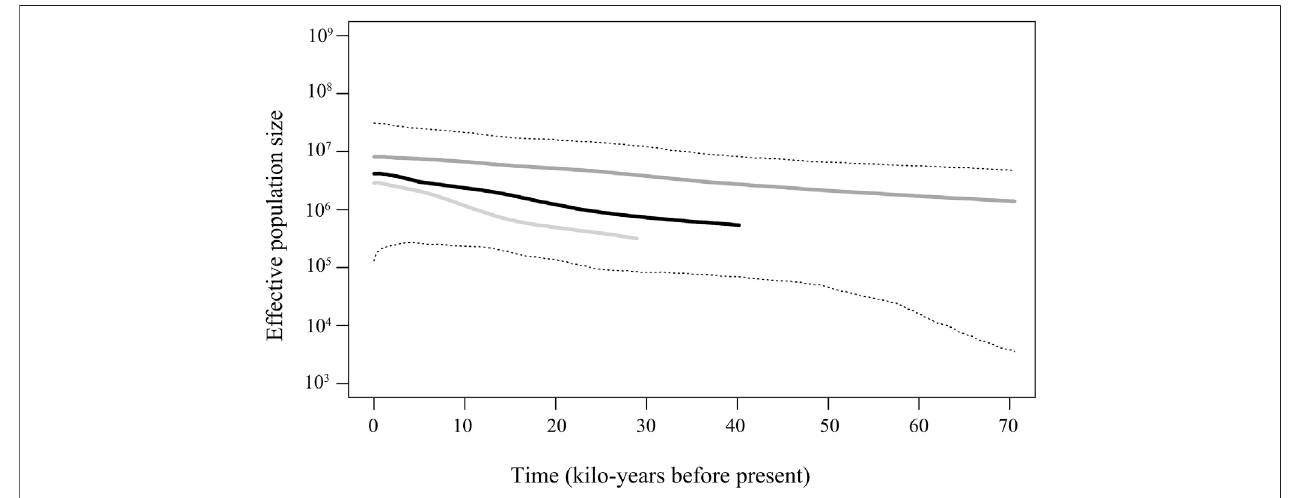
FIGURE5| Bayesianskyline plotrevealingthedemographictrends of Evynniscardinalis inBeibu Gulf.Thedarksolidlineismedianestimateundertheassumption of a 2% mutation rate per million years. The dark gray solid line shows the median given the assumption ofa 1% mutation rate per million, while the light gray bottom line shows the median obtained under the assumption of a 3% mutation rate per million years, and the dashed lines show the 95% highest posterior density (HPD) limits.